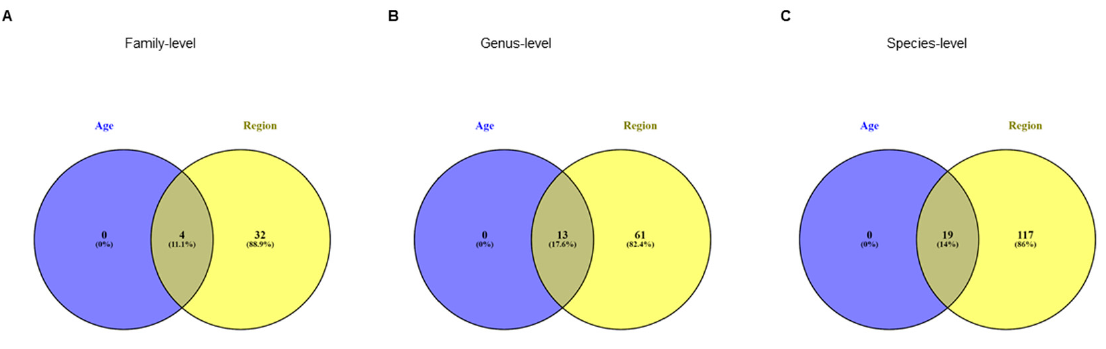
Figure 3. Venn diagrams showing the number of distinct and shared families ( A ), genera ( B ) and species ( C ) between subjects grouped by age classes and by regions.